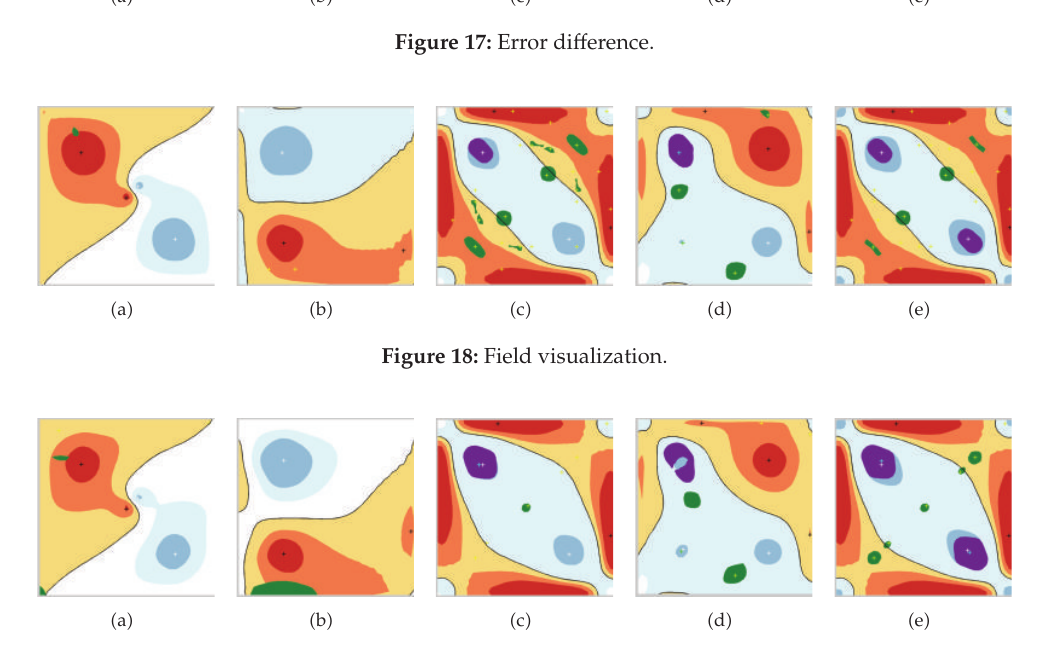
Figure 19: Order 4 field